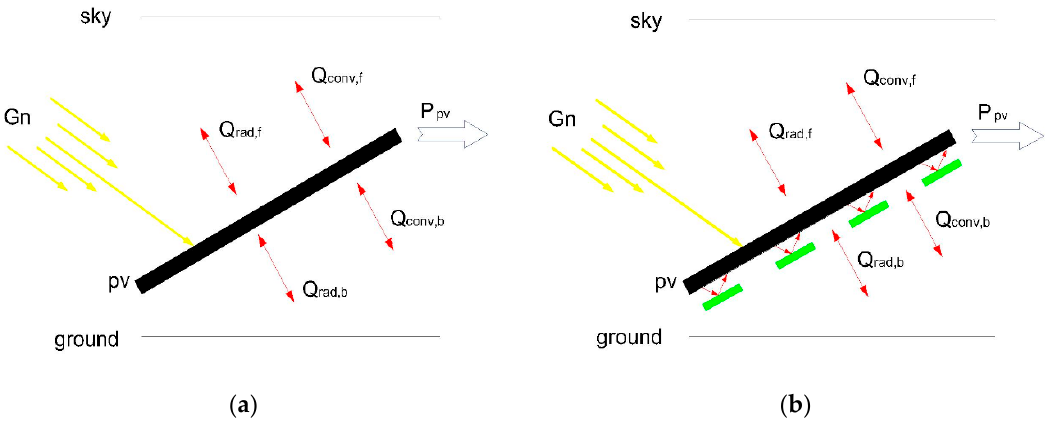
Figure 2. Heat exchanges of PV module: ( a ) without battery storage system; ( b ) with storage battery system. G n is the specific radiation incident on the module’s surface (W/m 2 ); P pv (W) is the electrical power generation, proportional to the total incident power; η is the photovoltaic conversion efficiency; G rif is the total radiative power reflected from the surface of the PV module that is proportional to the reflection index ρ .